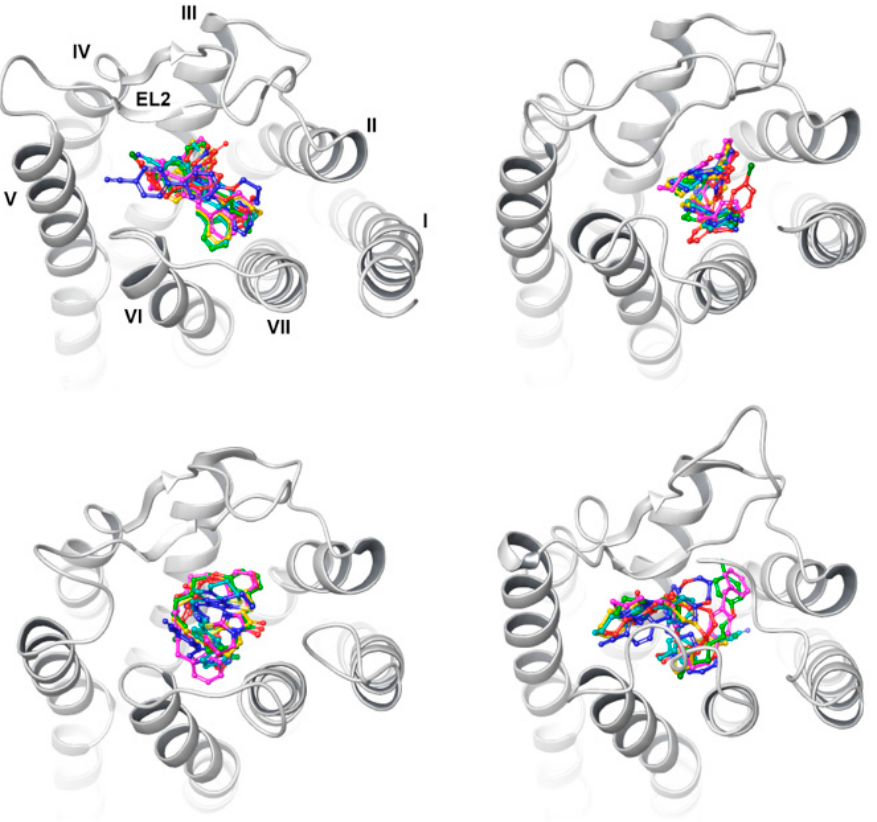
Figure 7. Top view of putative binding poses of the docked ligand set to IT ( top left ), CIT ( top right ), PY3 ( bottom left ), and TR ( bottom right ) models. Roman numerals indicate TMs—only marked in IT model for clarity purposes. For a colored figure, please refer to the online version of this paper.